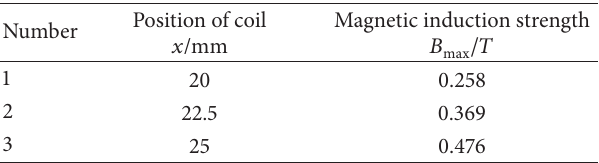
Table 1: Simulated results of magnetic induction strength at coil’s different